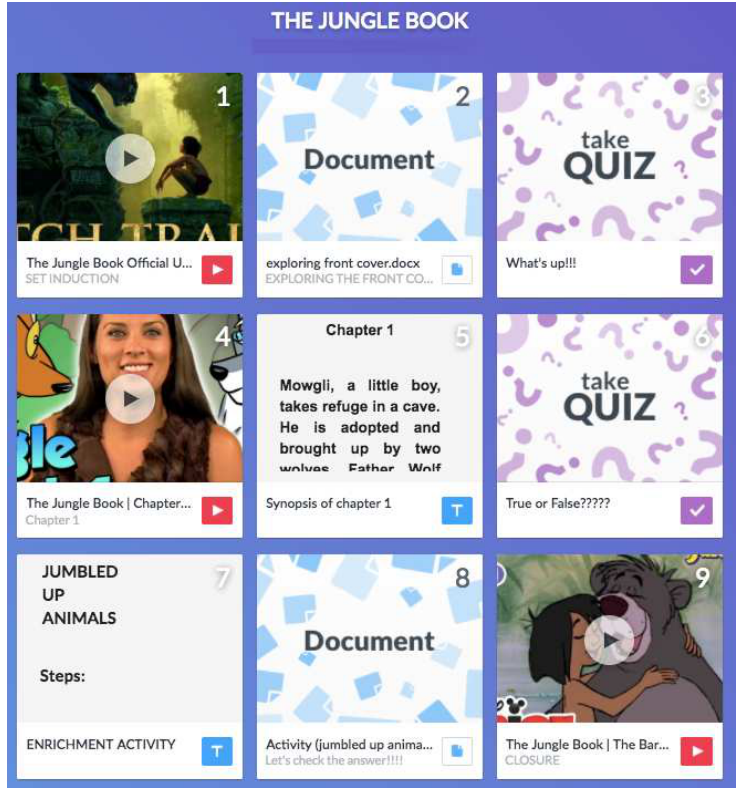
Figure 7: Anggerik’s Blendspace